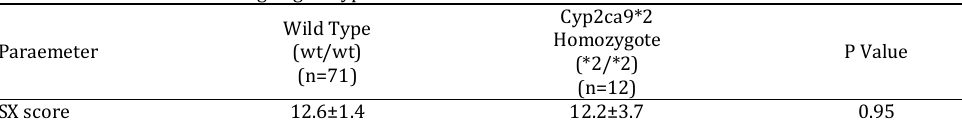
Figure 1. Association of CYP2C19 polymorphism and pattern of coronary artery disease Table 3. SYNTAX score according to